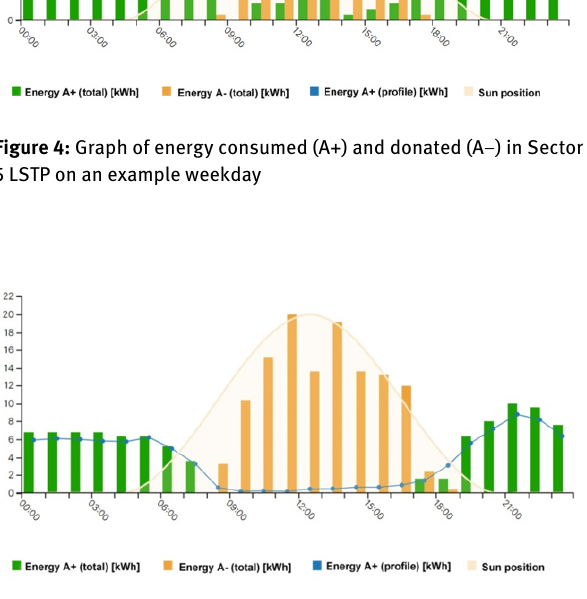
Figure 5: Graph of energy consumed (A+) and donated (A − ) in Sector 5 LSTP on an example weekend day